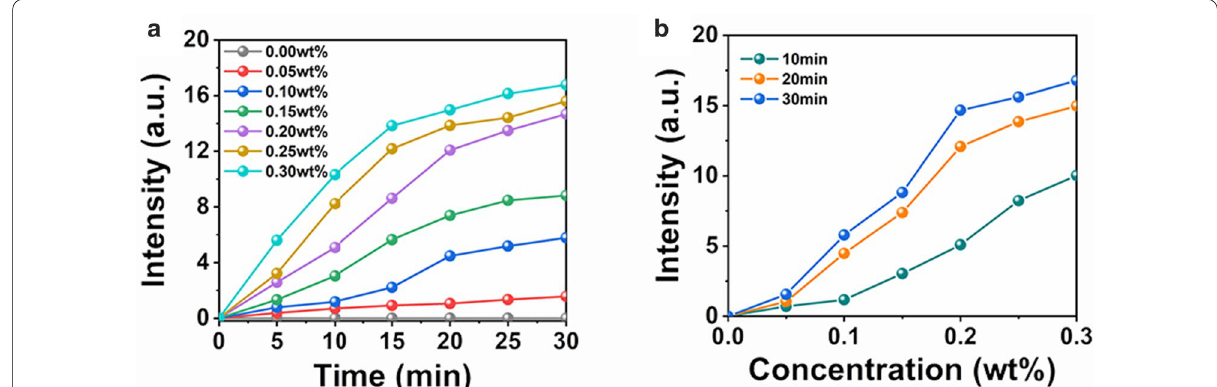
Fig. 3 Singlet oxygen production of composite nanofiber membrane doped with UCNPs@Curcumin exposed to 808‑nm light at different a concentration and b irradiation